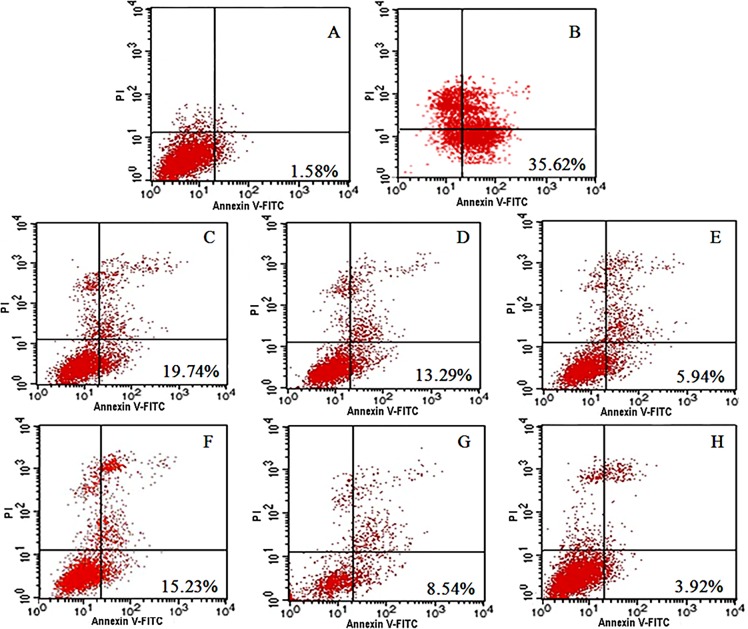
Flow cytometry results on PC-12 cells.(A) Blank PC-12 cells. (B) 6-OHDA diseased PC-12 cells without treatment. (C) 6-OHDA diseased PC-12 cells with 1nM SP solution treatment. (D) 6-OHDA diseased PC-12 cells with 10nM SP solution treatment. (E) 6-OHDA diseased PC-12 cells with 100nM SP solution treatment. (F) 6-OHDA diseased PC-12 cells with 1nM SP-GNP treatment. (G) 6-OHDA diseased PC-12 cells with 10nM SP-GNP treatment. (H) 6-OHDA diseased PC-12 cells with 100nM SP-GNP treatment.